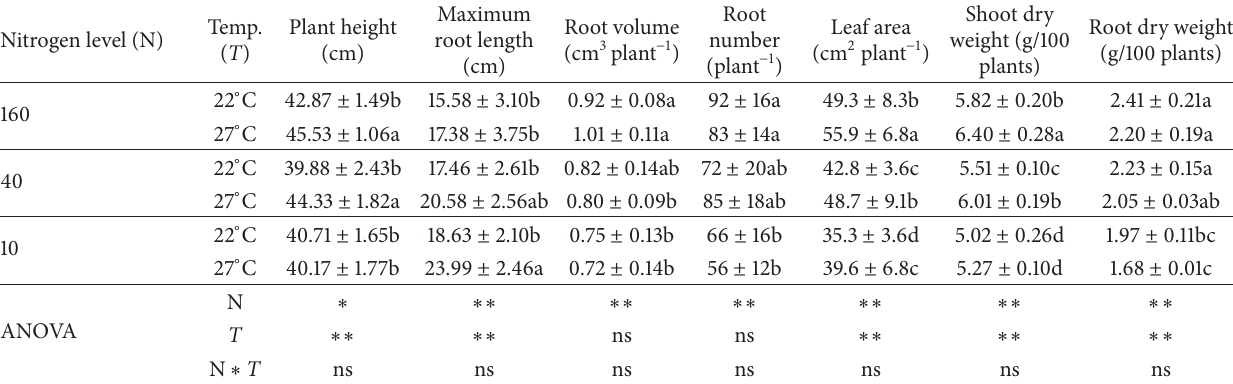
Table 1: Night temperature effect on the plant height, maximum root length, root volume, root number, leaf area, and shoot and root dry weights of rice